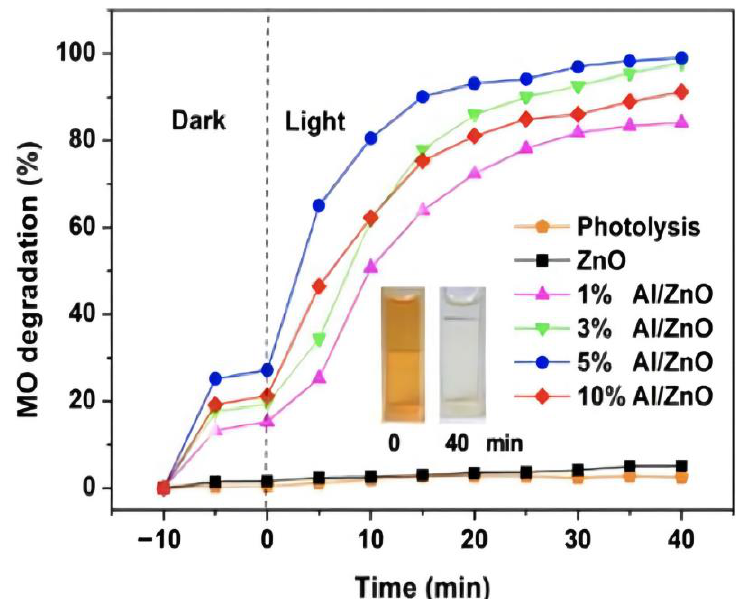
Figure 3. Photocatalytic efficiency of aluminum doping with different content (inset shows the color change in MO at time intervals 0 and 40 min).